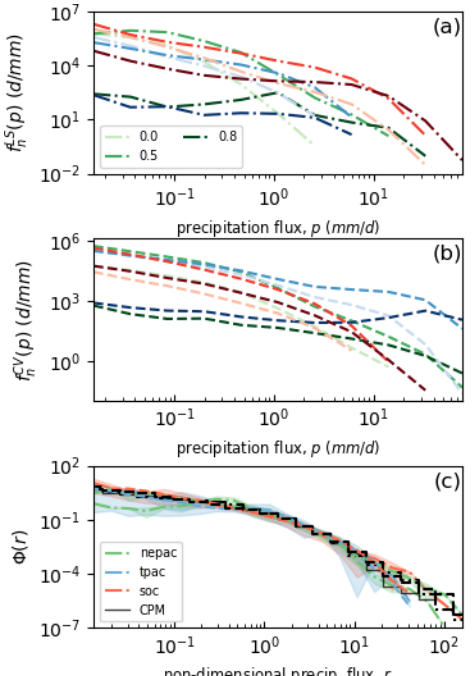
Figure 11. The cloud-albedo dependencies of the rainfall rate dis- tributions in a 20-year AMIP simulation for three geographical regions (the north-eastern Pacific (green lines), the tropical Pa- cific (blue lines) and Southern Ocean (green lines)). The simu- lated large-scale rainfall (a) and convection-scheme rainfall (b) fre- quency distributions for each cloud-albedo interval, for the three re- gions. The degree of shading for each colour shows the CDNCs. (c) The rescaled distributions (lines) and average universal histograms (black lines) for each regime. The solid black line shows the non- dimensional distribution from the May 2016 subtropical case